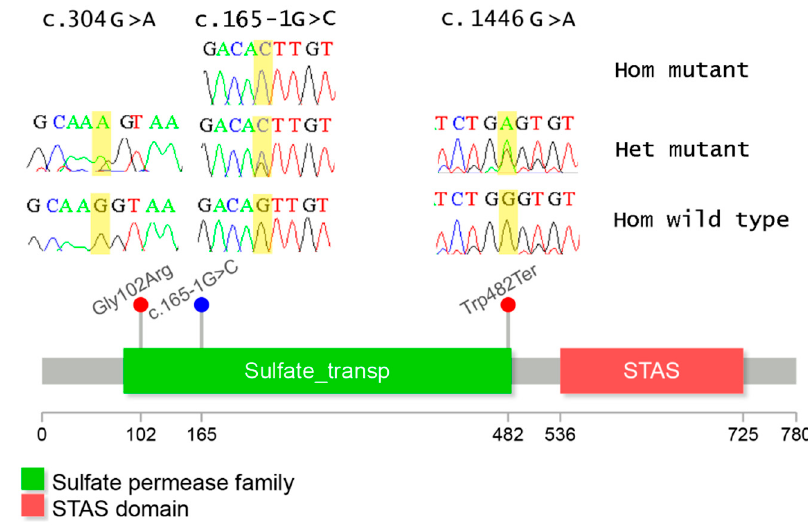
Figure 3. Schematic representation of the location of the variants in SLC26A6. The upper pane represents the corresponding chromatograms of the identified variants. Variant locus is highlighted in yellow. Black peak, G base; blue peak, C base; red peak, T base; green peak, A base. Abbreviations: Hom: homozygous, Het: Heterozygous.